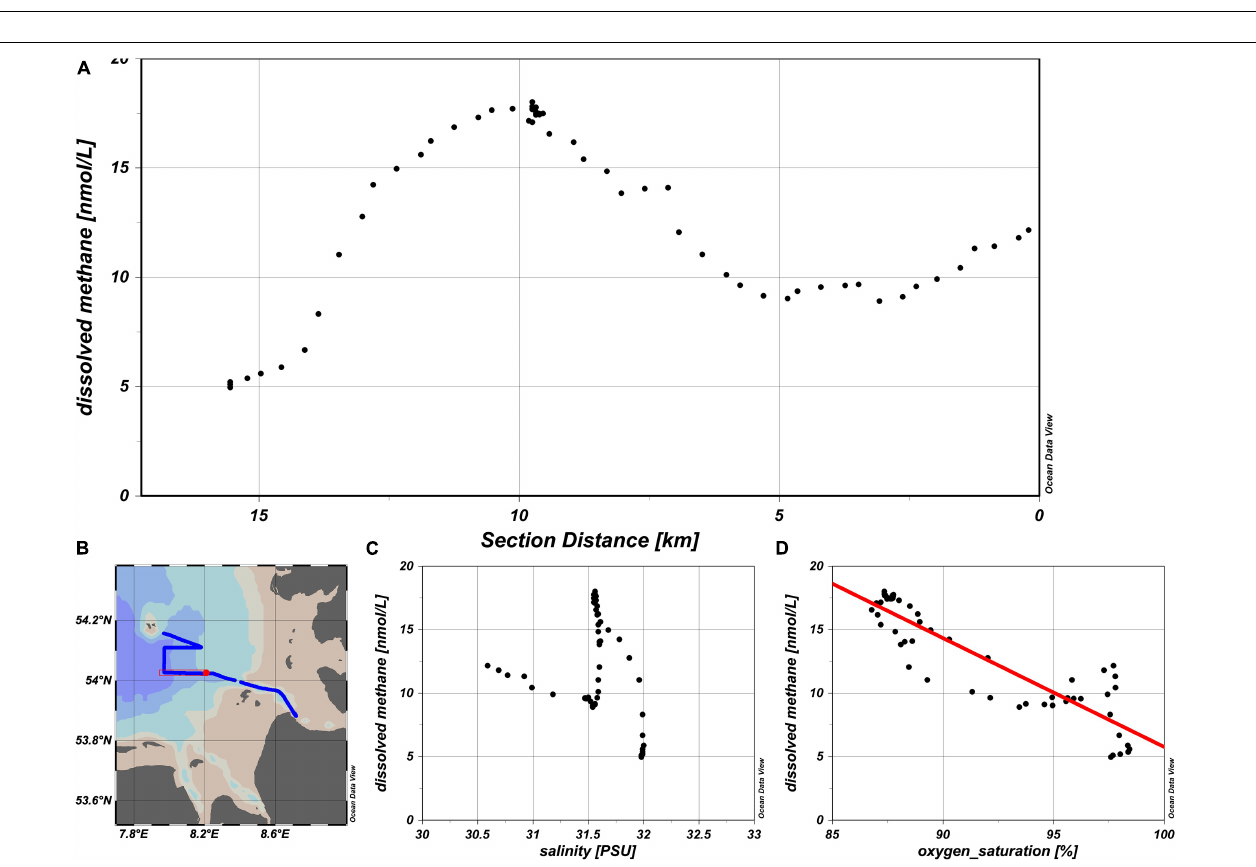
FIGURE 5 | A small-scale increase of methane (A) with the corresponding oxygen saturation (D) . The section is shown in (B) , and the section distance is recorded from east to west, starting with the red dot. Shown is also the correlation to salinity (C)